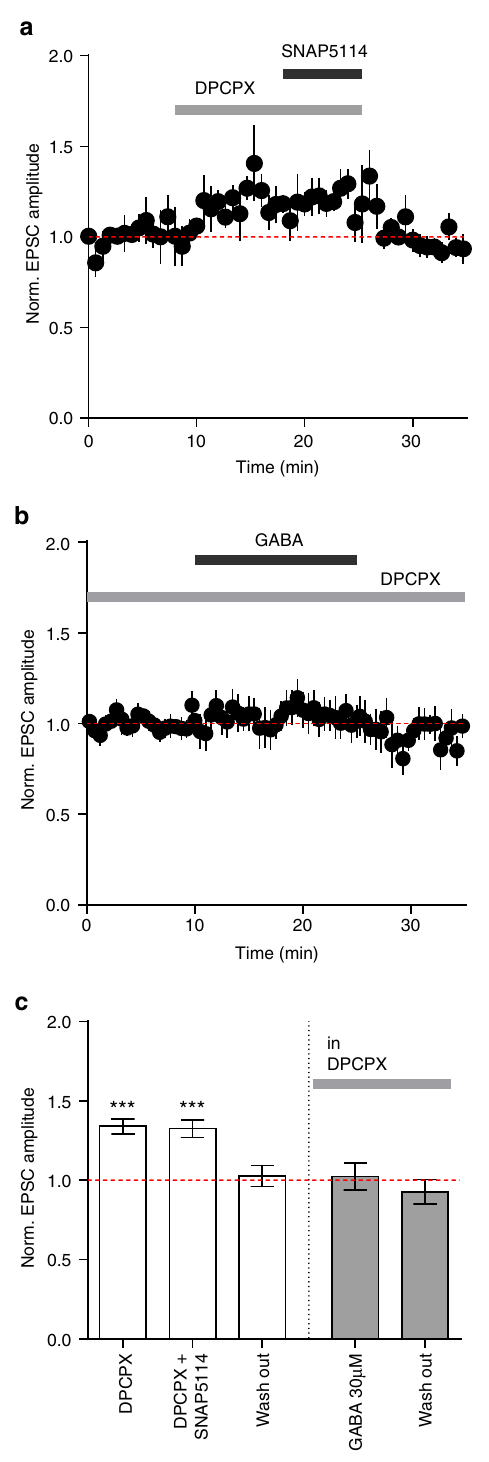
Figure 7 | GAT-3-mediated EPSC inhibition depends on astrocytic Ca 2 þ signalling and ATP/adenosine release. ( a ) A 1 antagonist DPCPX (10 m M) increases amplitude of EPSCs and occludes the effect of SNAP5114 ( n ¼ 6 cells from 4 animals). ( b ) In all, 30 m M GABA in the presence of DPCPX does not alter EPSC amplitude ( n ¼ 7 cells from 4 animals). ( c ) Summary plot showing the effects of DPCPX alone, and SNAP5114 and GABA in the presence of DPCPX on normalized EPSC amplitudes. Error bars represent s.e.m.’s, *** P o 0.001 (paired t -test compared with baseline).